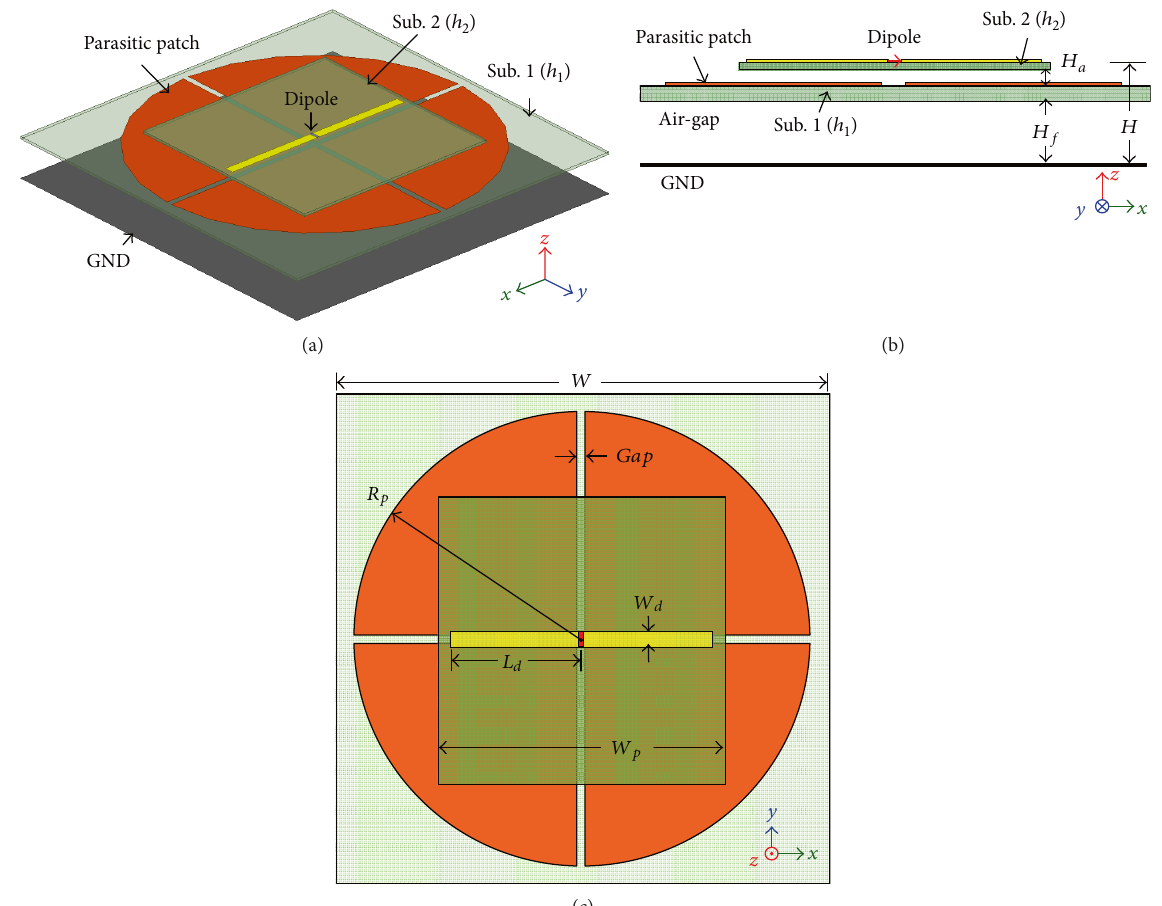
Figure 1: Geometry of a printed dipole loaded with parasitic patches: (a) perspective view, (b) side view, and (c) top